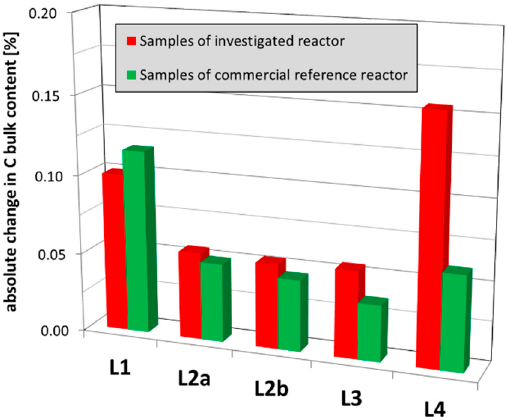
Figure 10. Comparison of absolute changes in carbon (C) bulk contents of used catalyst samples from the investigated reactor and the commercial reference reactor. The samples of each layer were averaged.